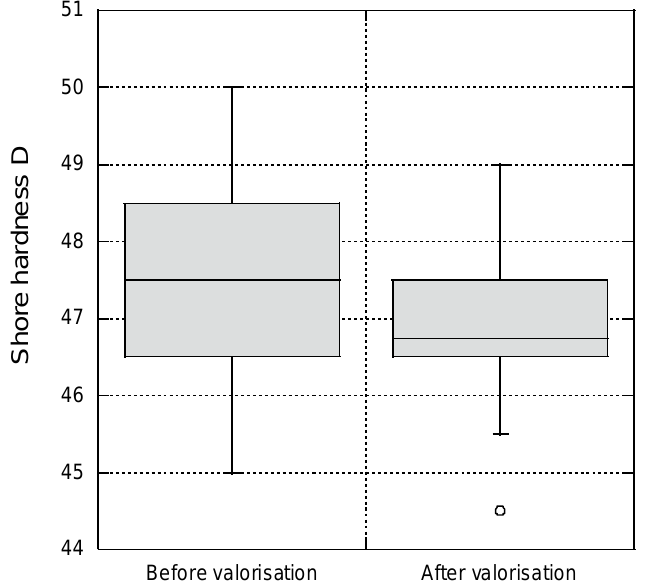
Figure 10. Shore hardness of polyethylene before and after being recycled.